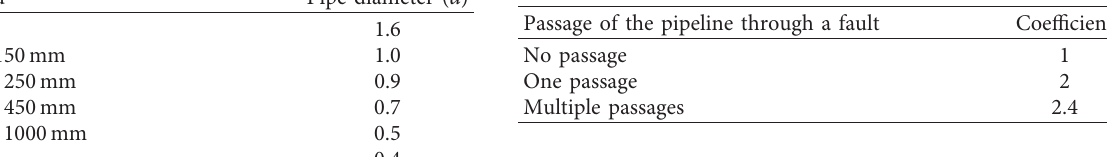
Table 7: Weighted coefficient for passage of the pipeline through the fault.